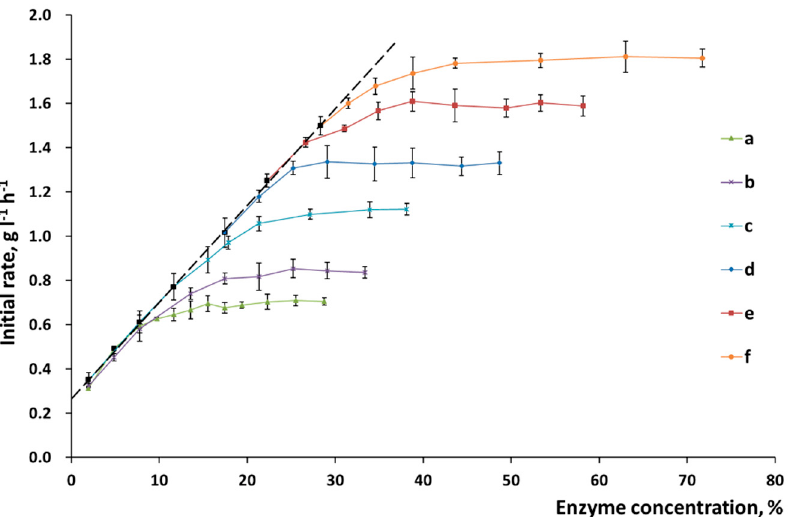
Figure 4. The initial rate of hydrolysis of α -cellulose after mechanical activation: ( a ) without activation and after activation for ( b ) 2 min; ( c ) 5 min; ( d ) 10 min; ( e ) 20 min; and ( f ) 30 min.